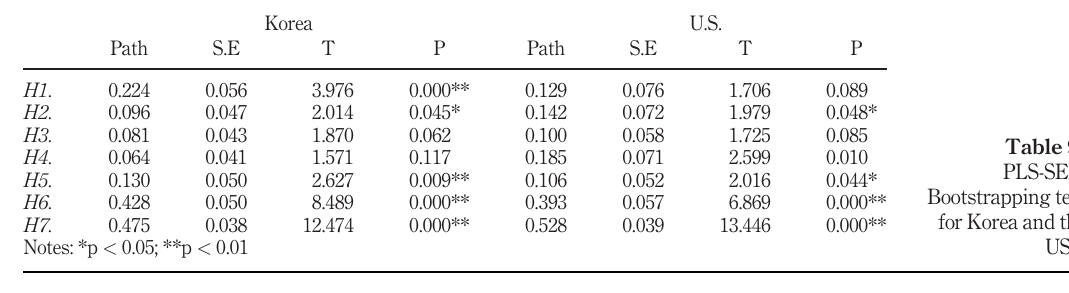
Bootstrapping test